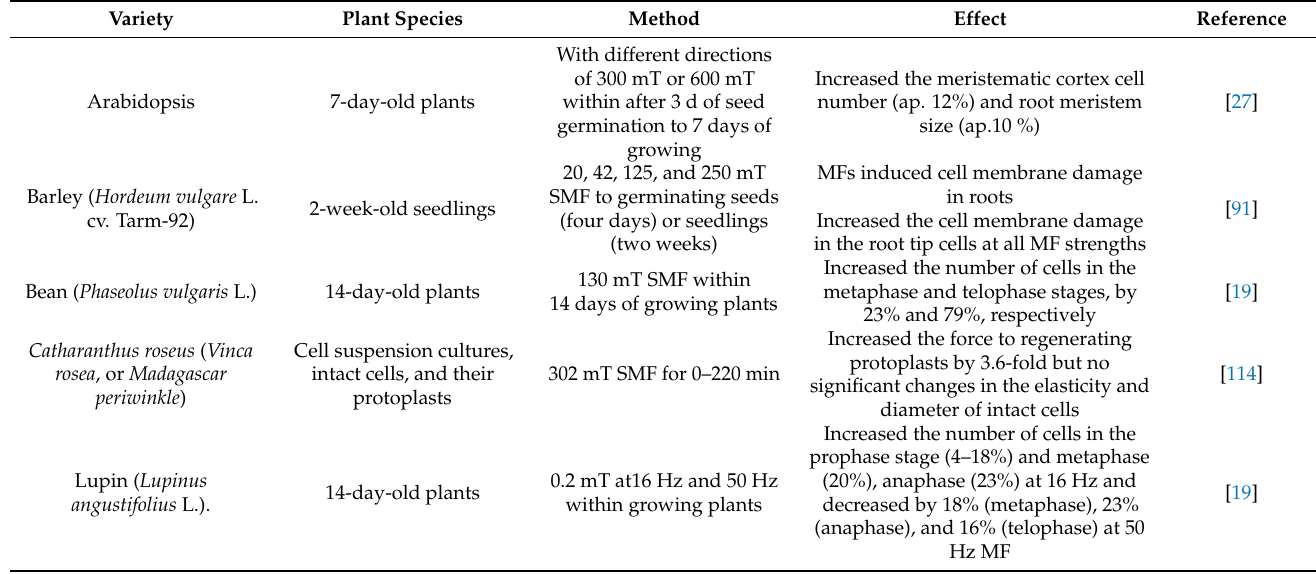
Table 3. Effects of MFs on structure and cell